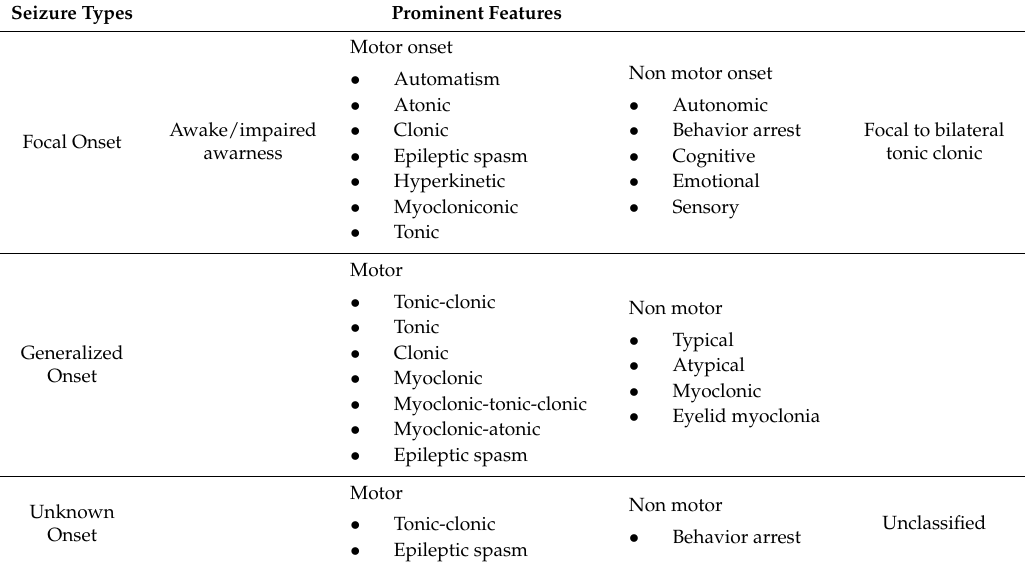
Table 1. Classification of seizure types-expanded version